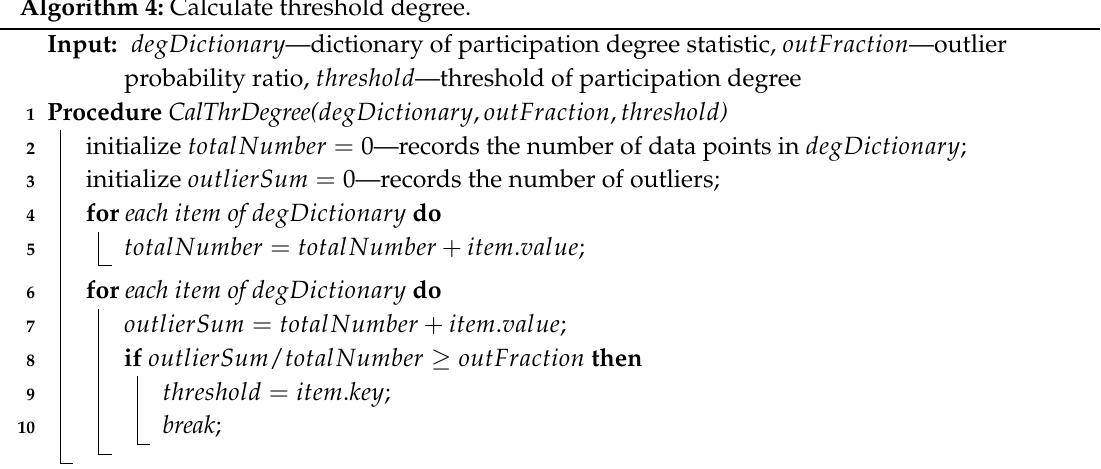
Algorithm 4: Calculate threshold degree.